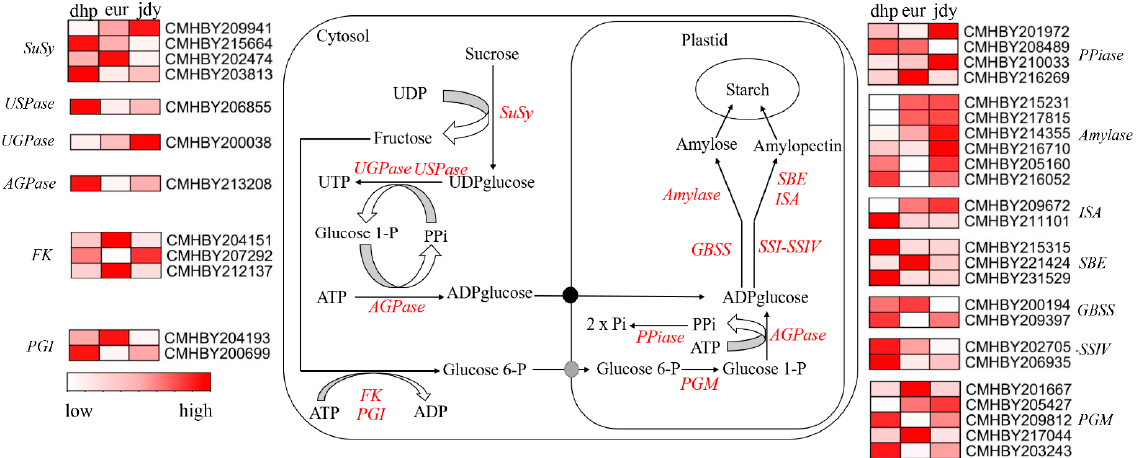
Figure 6. Schematic model of starch biosynthesis in chestnut kernels. Sucrose synthase (SuSy), UDPG pyrophosphorylase (UGPase), UDP-sugar pyrophosphorylase (USPase), adenosine diphosphate glucose pyrophosphorylase (AGPase), fructokinase (FK), phosphoglucose isomerase (PGI), phosphoglucomutase (PGM), pyrophosphatase (PPiase), granule-bound starch synthase (GBSS), soluble starch synthase (SSI-SSIV), amylase (Amylase), starch branching enzyme (SBE), isoamylase (ISA).